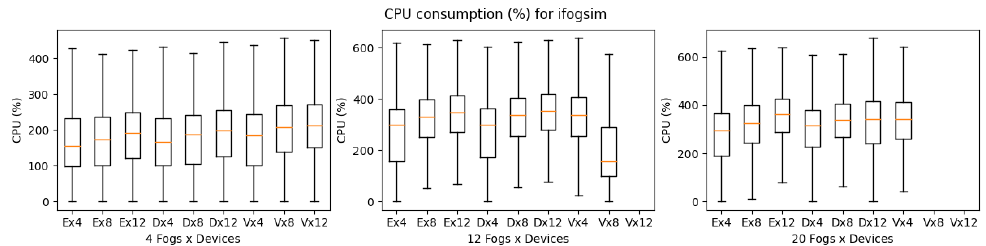
Figure 11. CPU consumption for iFogSim during simulation (E: eHealth; D: DCNS; V: VRGame).